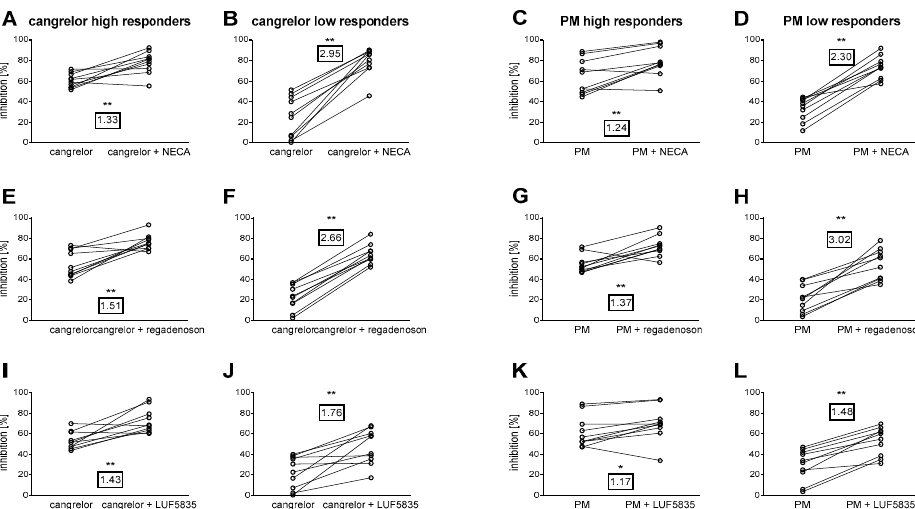
Figure 3. Anti-platelet e ff ect of AR agonists in high- and low-responders to P2Y 12 antagonists. Combinations of cangrelor ( A , B , E , F , I , J ), and PM ( C , D , G , H , K , L ) with NECA ( A – D ) regadenoson ( E – H ), and LUF5835 ( I – L ) are shown. Framed numbers denote the mean inhibition increase factor (arithmetic mean of ratios calculated individually for each donor). Data are shown as pairs of data points (without and with AR agonist) for each blood donor ( n = 10 in each group). Changes in platelet aggregation were measured in whole blood in response to 10 µ M ADP after 3 min preincubation at 37 ◦ C with AR agonist and cangrelor, or 15 min preincubation at 37 ◦ C with AR agonist and PM. Statistical significance between P2Y 12 inhibitor alone and P2Y 12 inhibitor with AR agonist groups for each agonist-antagonist pairing estimated by two-tailed Wilcoxon signed rank test. * p < 0.05, ** p < 0.01.